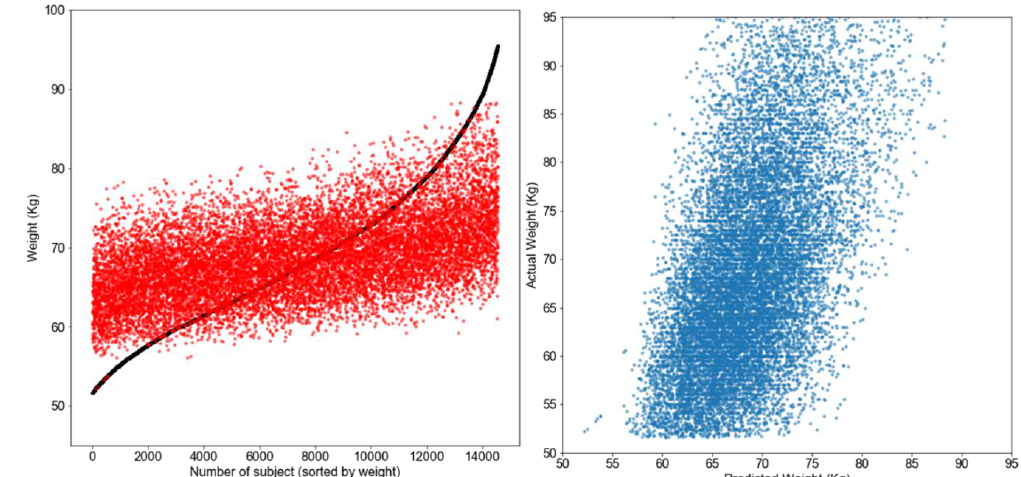
Figure 2. The left panel shows a scatter plot comparing the predicted and real weights against the weight index. The right panel shows a comparison between the predicted weights by kNN against the real weights. In the left panel, the red dots are the predicted weights and the black squares are the real weights.